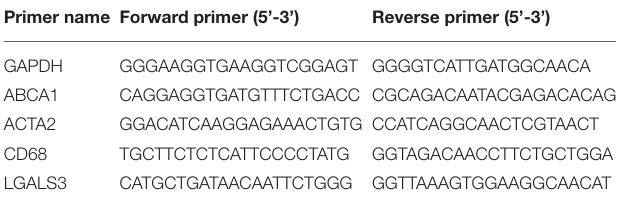
TABLE 1 | RT-qPCR primer